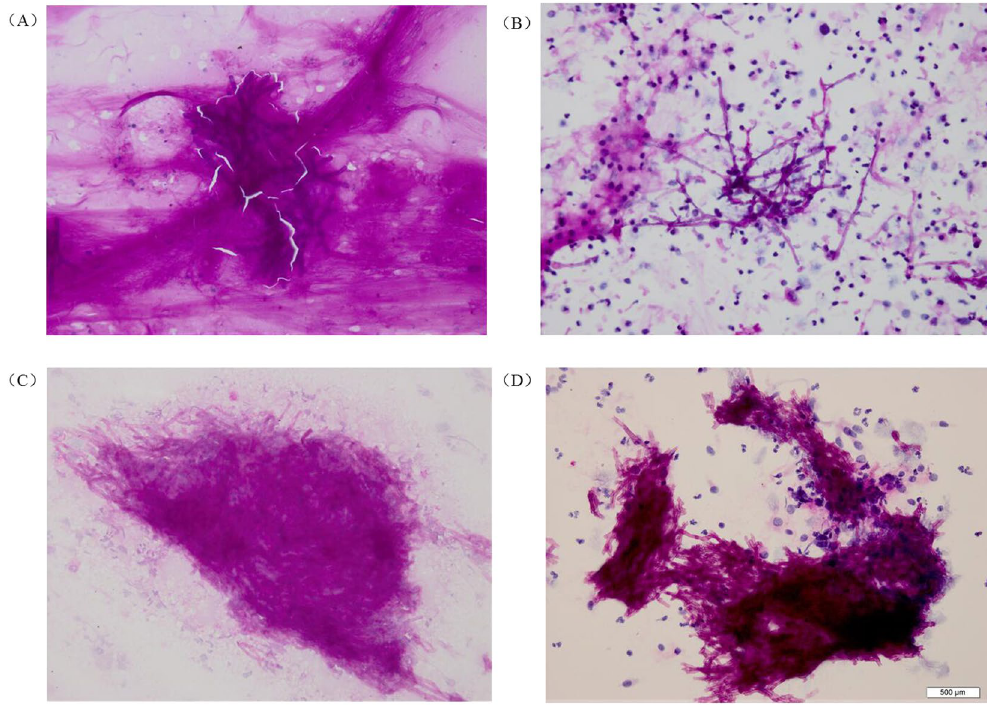
Figure 2. Cytomorphology of Aspergillus in sputum and bronchial brushing samples processed using the SurePath LCT platform or conventional cytopathology, followed by PAS staining. The mycelium of Aspergillus appeared magenta after PAS staining. Magnification, 400X. ( A ) Conventional PAS on sputum samples; ( B ) LCT- based PAS on sputum samples; ( C ) Conventional PAS on bronchial brushing samples; ( D ) LCT-based PAS on bronchial brushing samples. LCT: Liquid-based cytopathology; PAS: Periodic